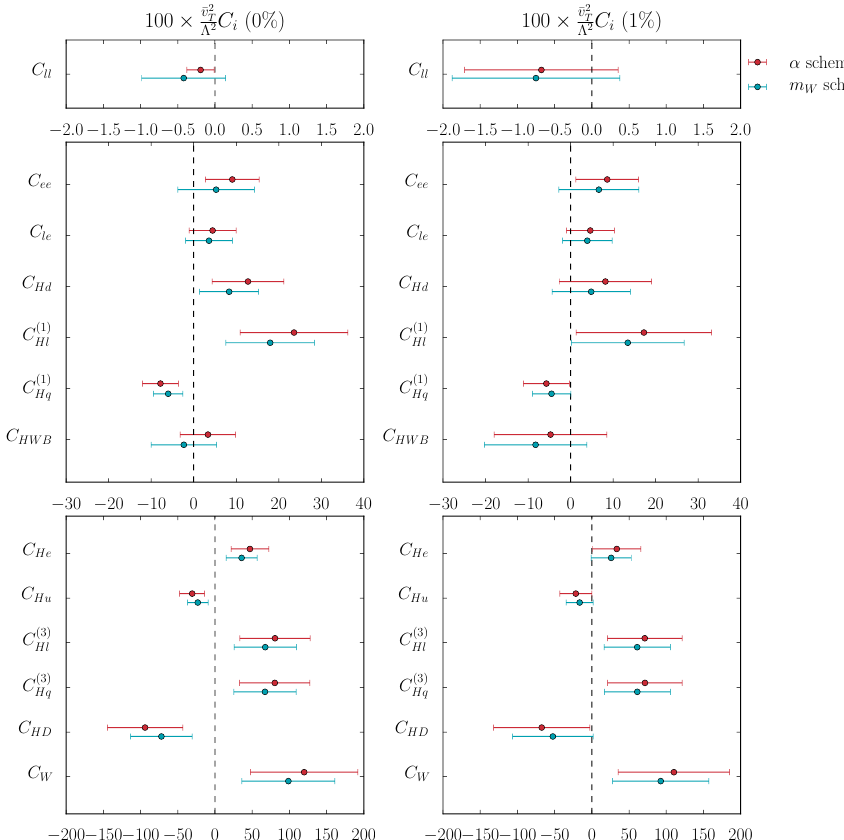
Figure 3 . Best (cid:12)t values of the Wilson coe(cid:14)cients (scaled by a factor 100) and corresponding 1 (cid:27) con(cid:12)dence regions obtained after pro(cid:12)ling away the other parameters. Red (blue) points were (cid:6) obtained in the ^ (cid:11) ( ^ m W ) ; ^ m Z ; ^ G F input parameter scheme. The plot to the left has been obtained f g assuming (cid:1) SMEFT = 0, while the one to the right includes a theoretical error (cid:1) SMEFT = 0 :